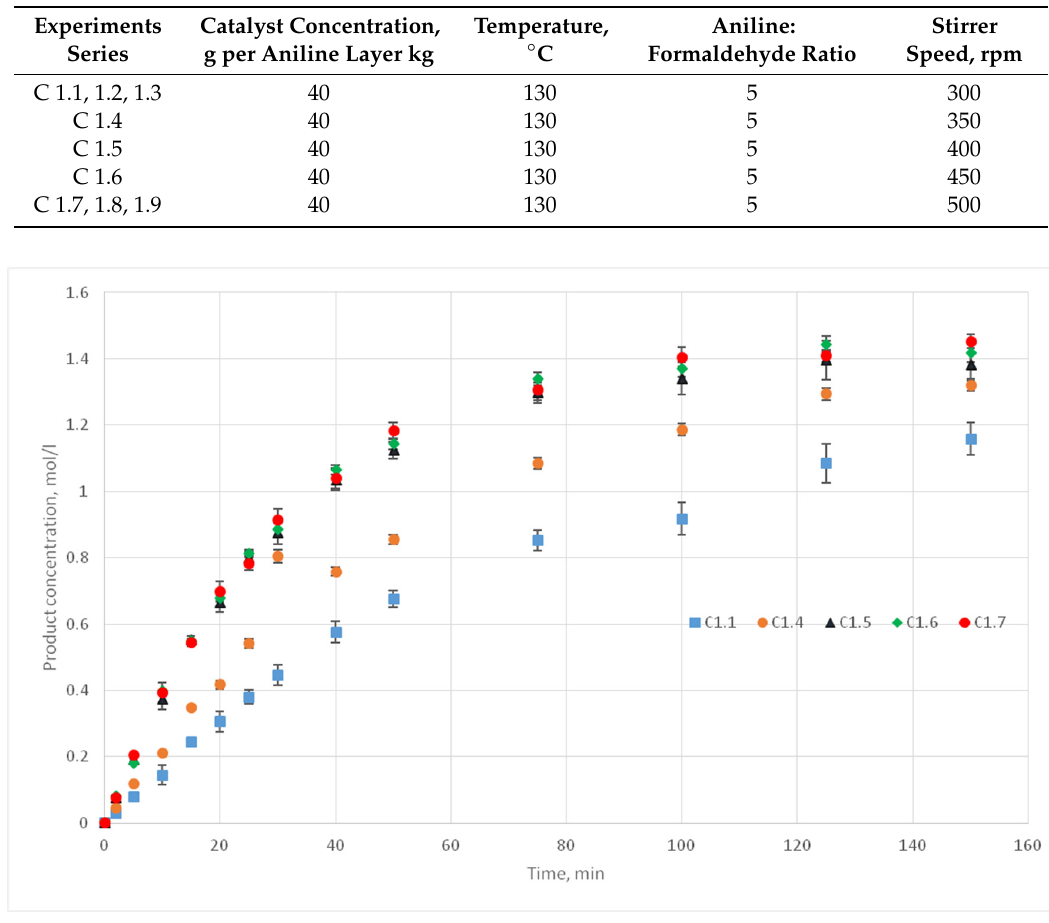
Figure 10. C1 series kinetic Figure 10. С 1 series kinetic curves.